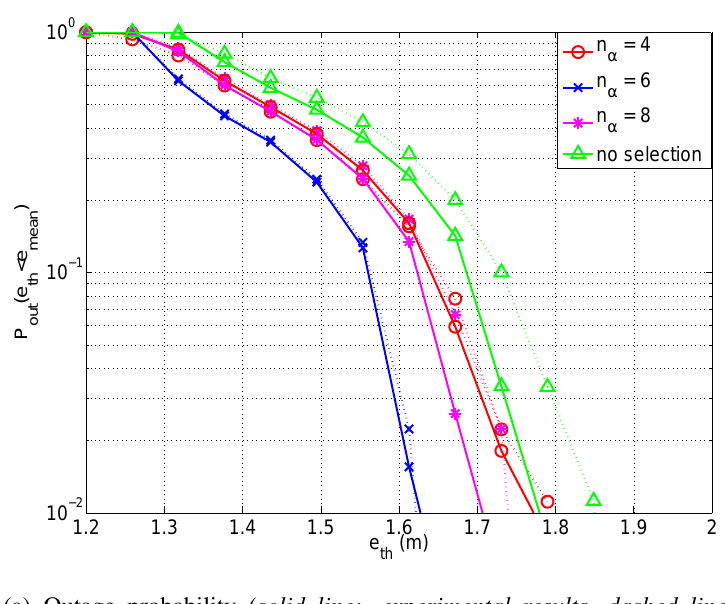
(b) Mean absolute error versus number of cooperating nodes ( n ) (solid line: experimental results, dashed line: δ simulation results) ) (solid line: exper- δ